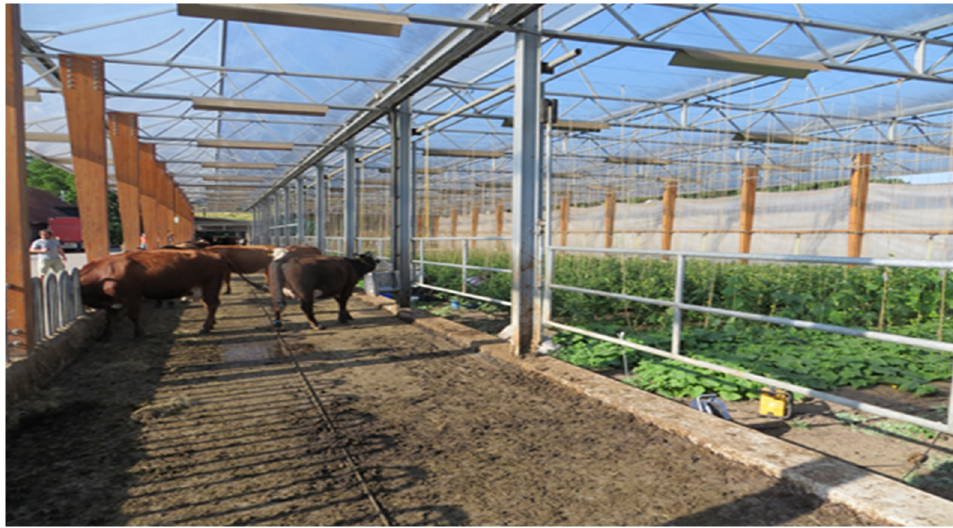
Figure 6. Utilizing a compost bedded-pack barn for growing horticultural products. Source: Farm Veld & Beek, Doorwerth, the Netherlands.